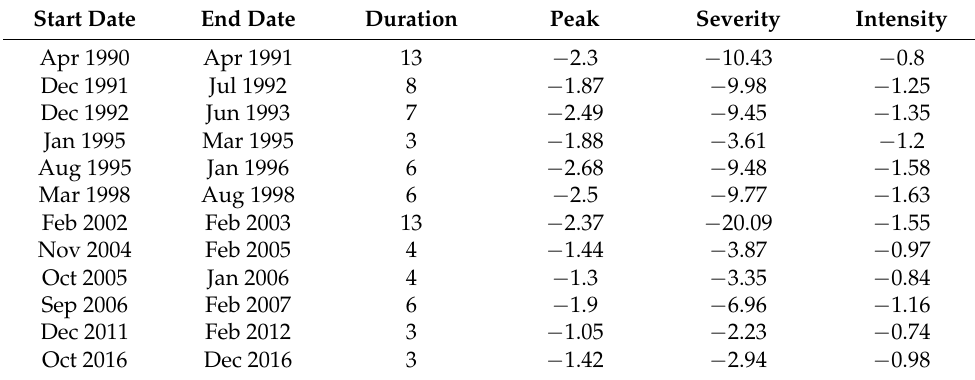
Table 4. Hydrological drought characteristics that occurred in the